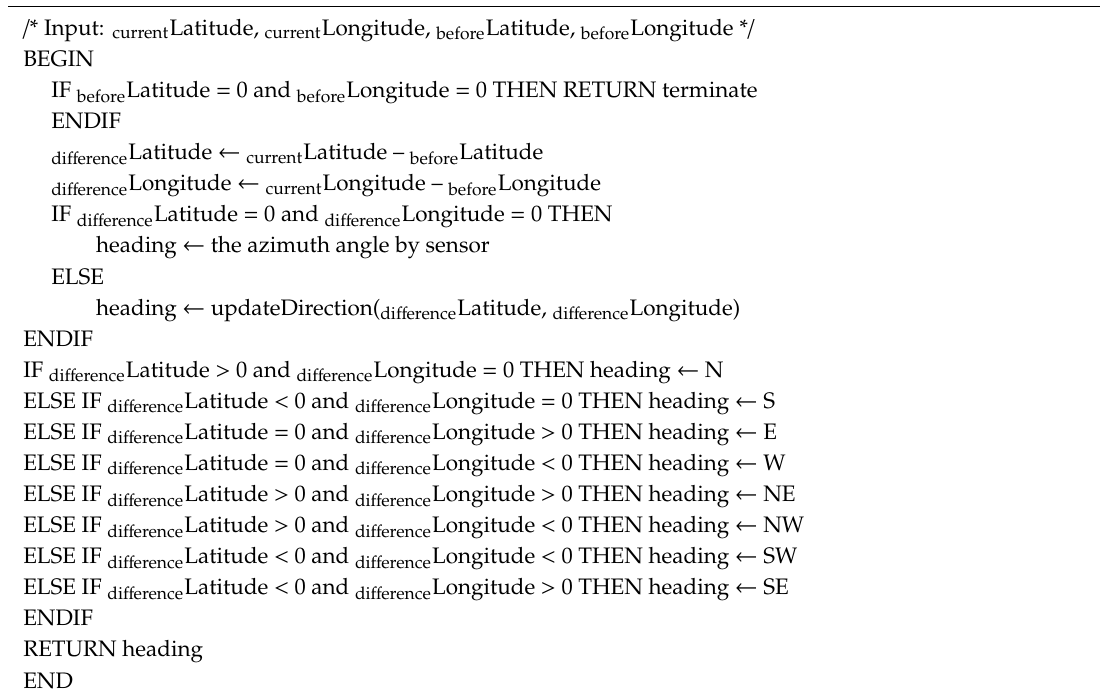
Algorithm 1 Determining the cardinal